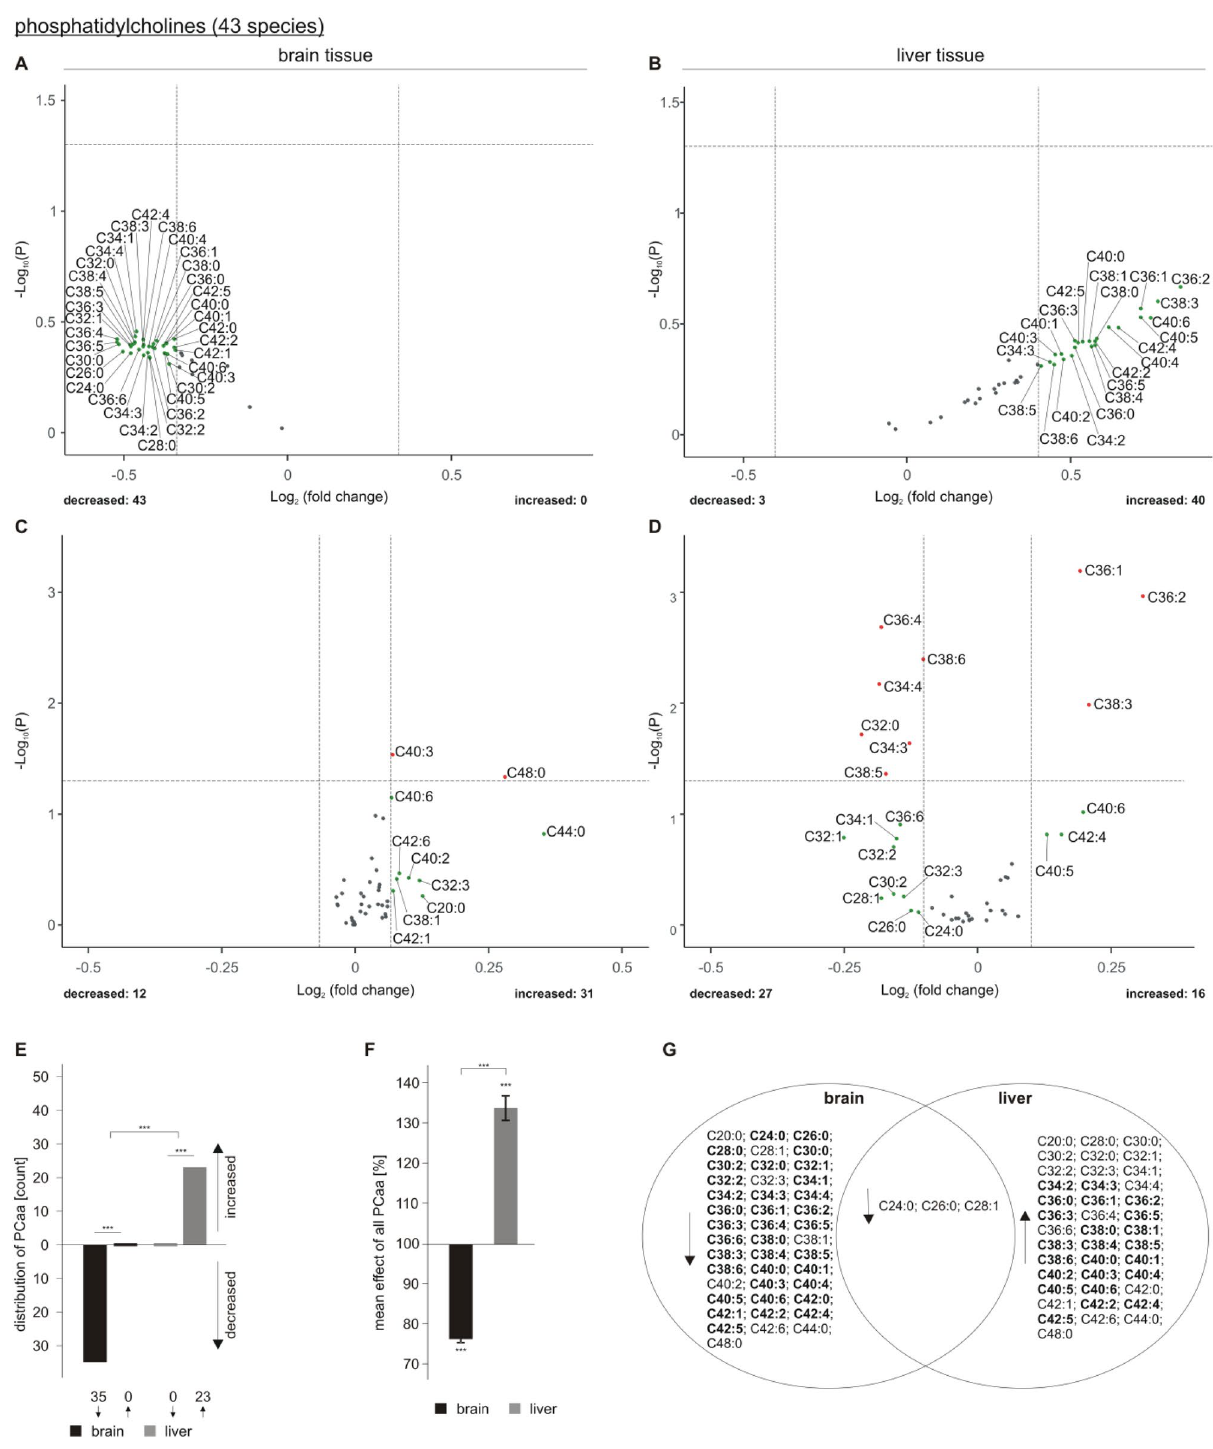
Figure 4. Changed phosphatidylcholine (PCaa) levels in 5xFAD brain and liver tissue after acitretin treatment. Fold changes of single PCaa species in brain and liver tissue are shown as volcano plots on the top ( A : brain tissue, B : liver tissue) and the effects of single species independent of lipid class effect for the analyzed species are presented as appropriate volcano plot on the bottom ( C : brain tissue, D : liver tissue). Structure and labeling of the volcano plots are according to Fig. 2. ( E ) Distribution of PCaa species represented as number of de- and increased parameters in brain and liver tissue in a bar chart. ( F ) Mean effects on all PCaa in brain and liver tissue are shown in a bar chart. Statistical significance for ( E ) and ( F ) was calculated according to Fig. 3. ( G ) Venn diagram showing exclusively changed as well as overlapping PCaa species in brain and liver tissue. Species with a fold change greater than the SEM are highlighted in